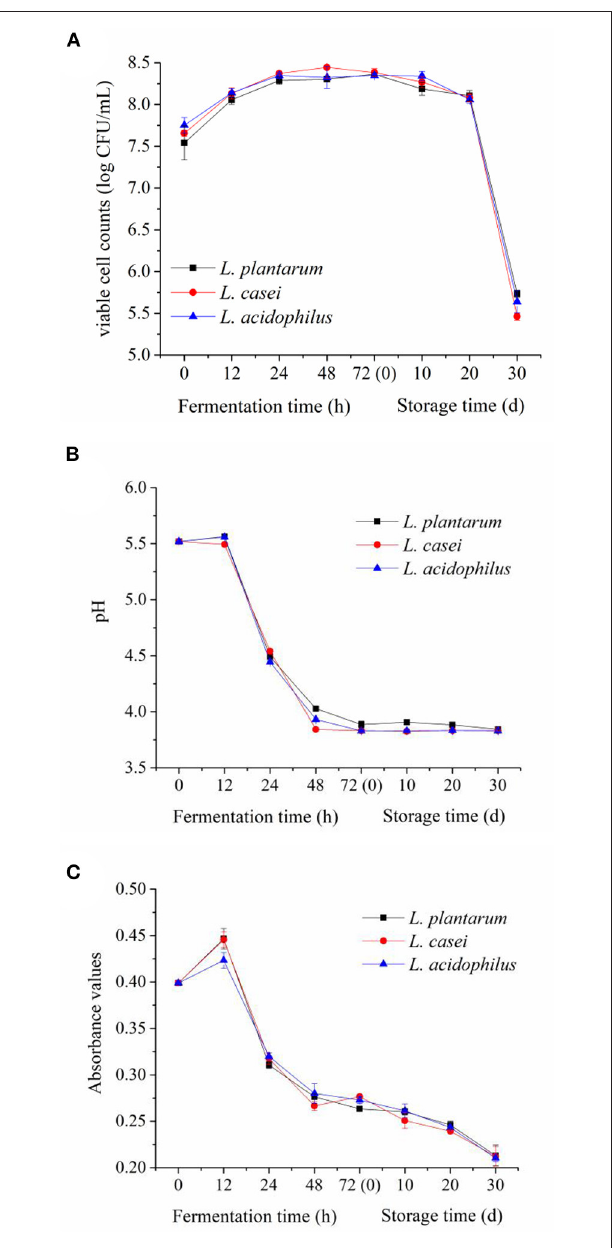
FIGURE 1 | Evolutions of viable cell counts (A) , pH value (B) and browning index (C) in apple juices fermented by the three LAB strains during fermentation and refrigerated storage (4 ◦ C, 30